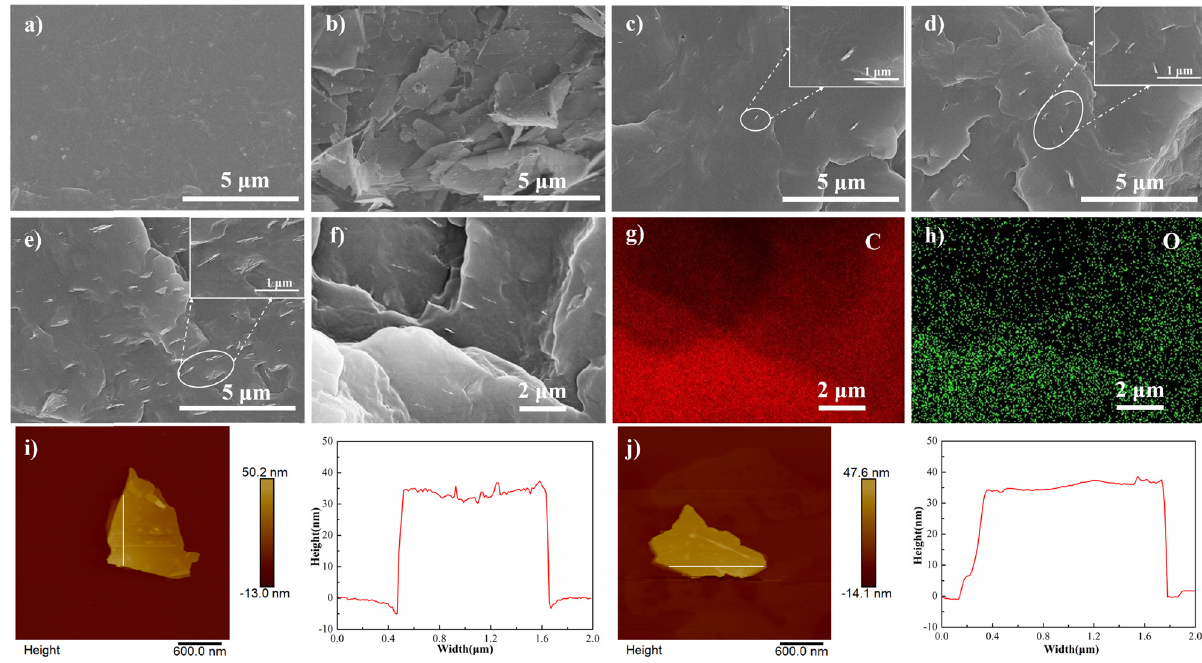
Figure 1: SEM images of neat PP ( a ) , GNP ( b ) , PP/G0.5 ( c ) , PP/G1.0 ( d ) , and PP/G3.5 ( e ) . High magni fi cation SEM images of PP/G1.0 ( f ) . EDS mapping of C and O of PP/G1.0 ( g and h ) . AFM images and height pro fi le along the white line of GNP ( i ) and PP/G1.0 ( j )